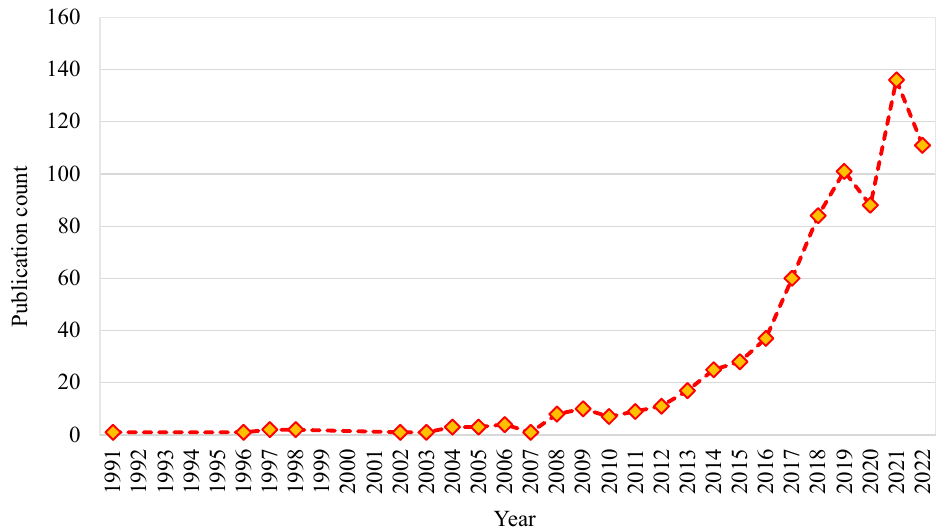
Figure 3. Kinds of documents available on FRGP studies.